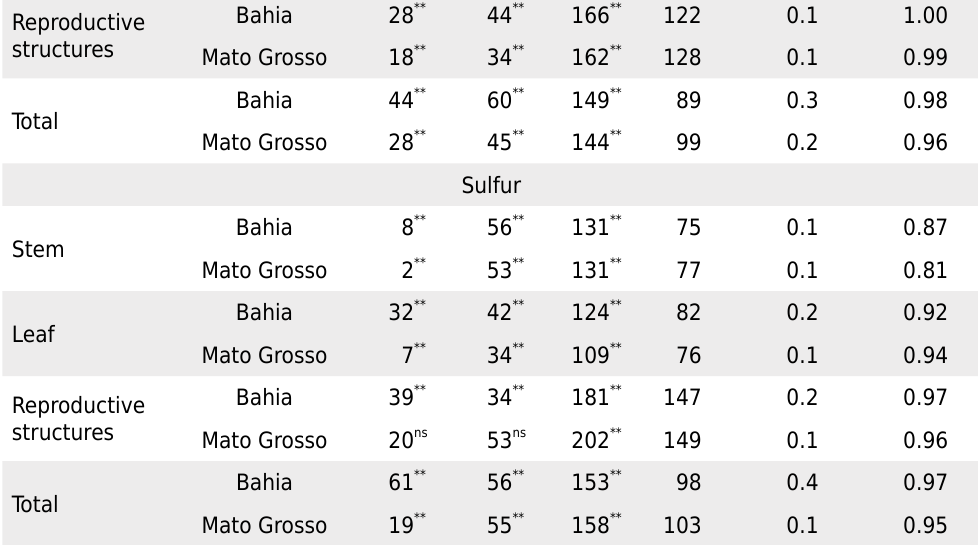
(1) Values represent the average of three varieties in Bahia and two varieties in Mato Grosso. (2) Value of maximum dry matter accumulation. (3) Amplitude in the value of x in DAE between the inflection point and the maximum point. (4) Days after emergence (DAE). ** , * , and ns: significant at 1 %, 5 %, and not significant by the t-test (p<0.05),